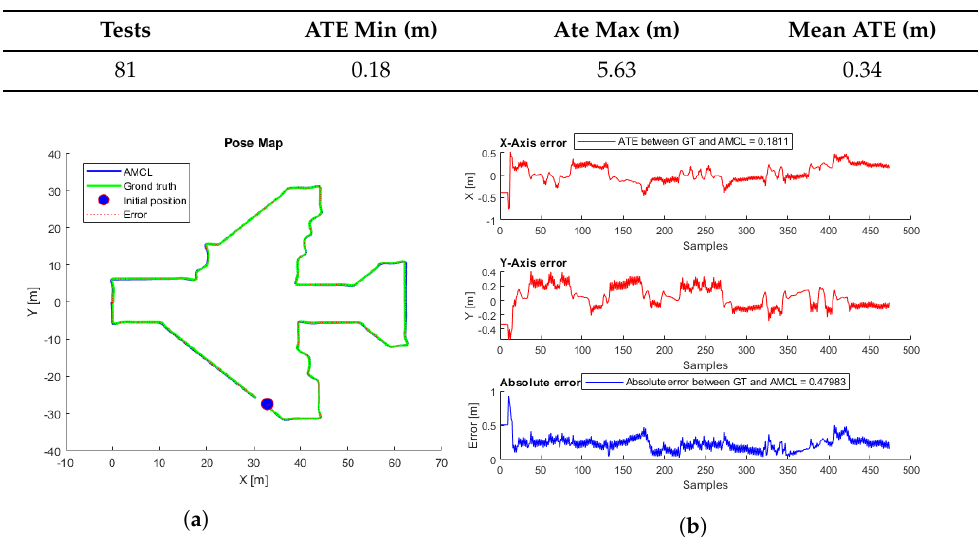
Table 2. Calculation of minimum, maximum, and average ATE for 81 simulated flights.